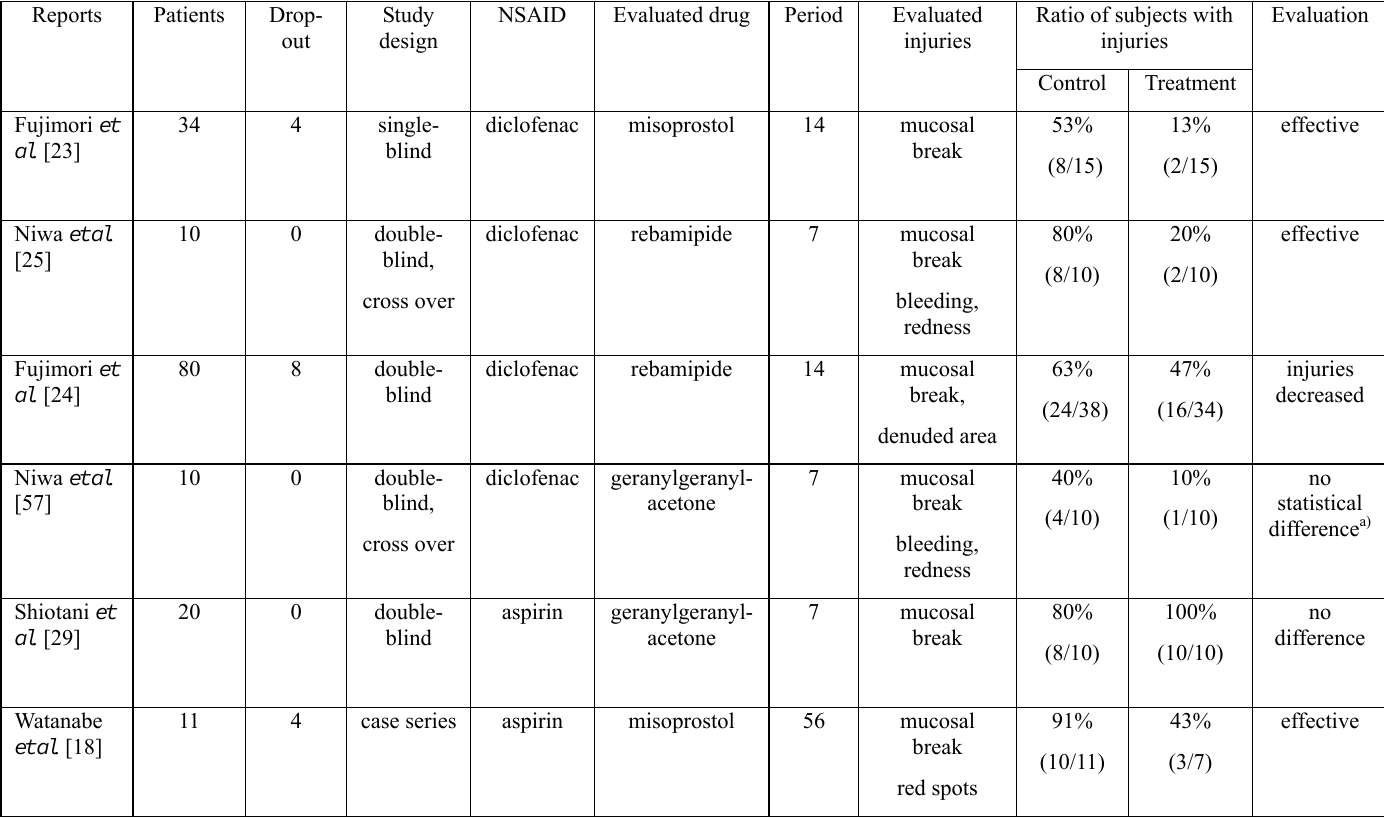
Table 1. Studies using capsule endoscopy to evaluate concomitant therapy against NSAID-induced small intestinal